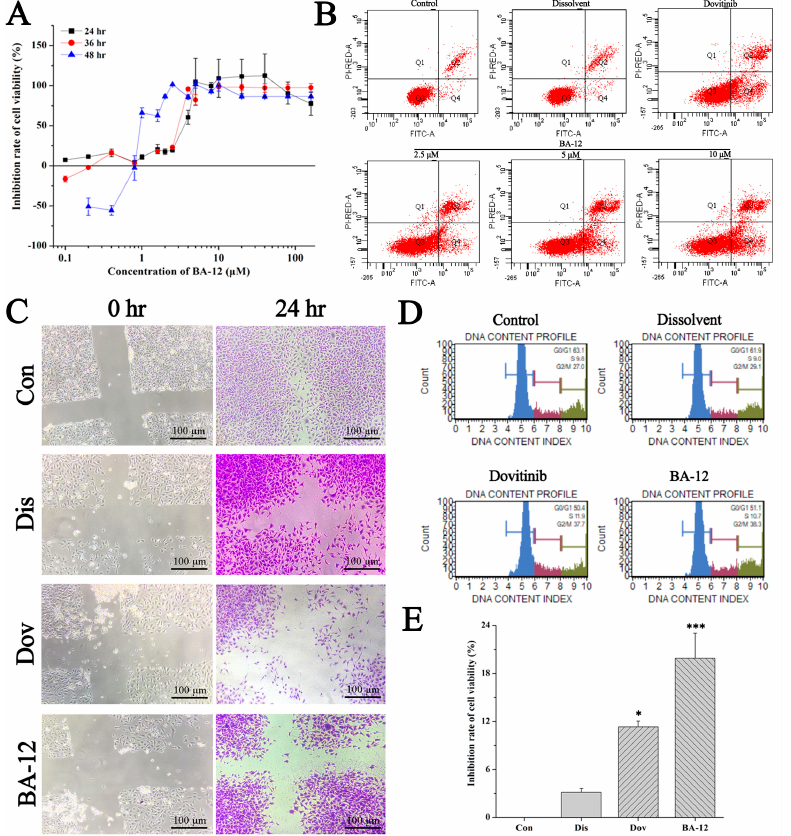
Figure 1. The in vitro antitumor activity of BA-12 on T24 cells. ( A ) Inhibition rate of cell viability of T24 cells for MTT assays (cells treated with BA-12 at doses of 0.25–160 µ M) for 24, 48, and 72 h. ( B )